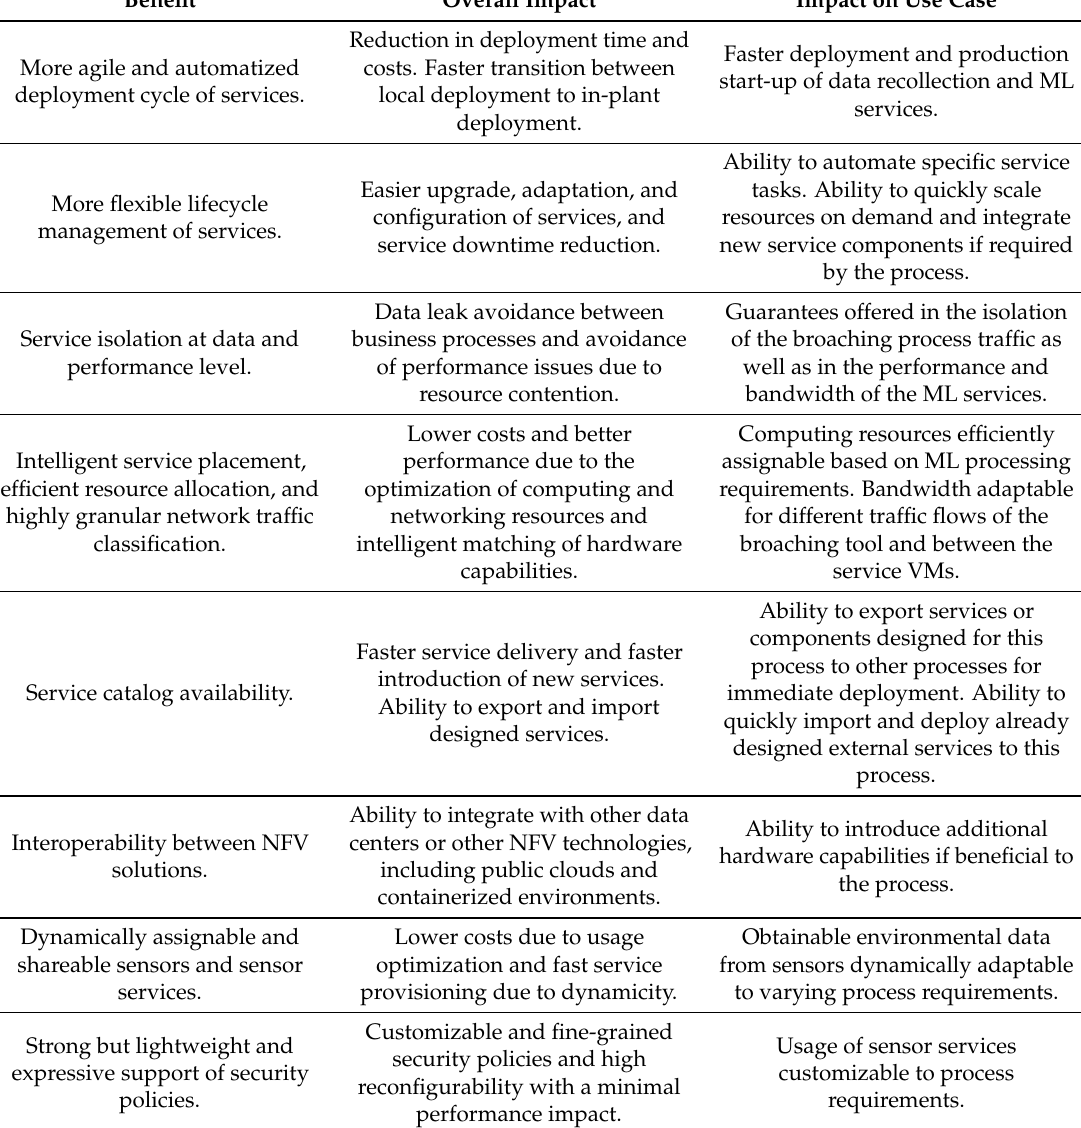
Table 1. Summary of